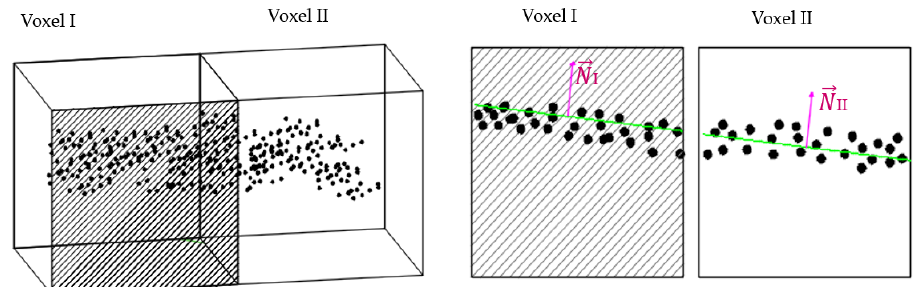
Figure 5. Adjoining voxels containing planar patches with similar normal orientations as candidates for the merging.